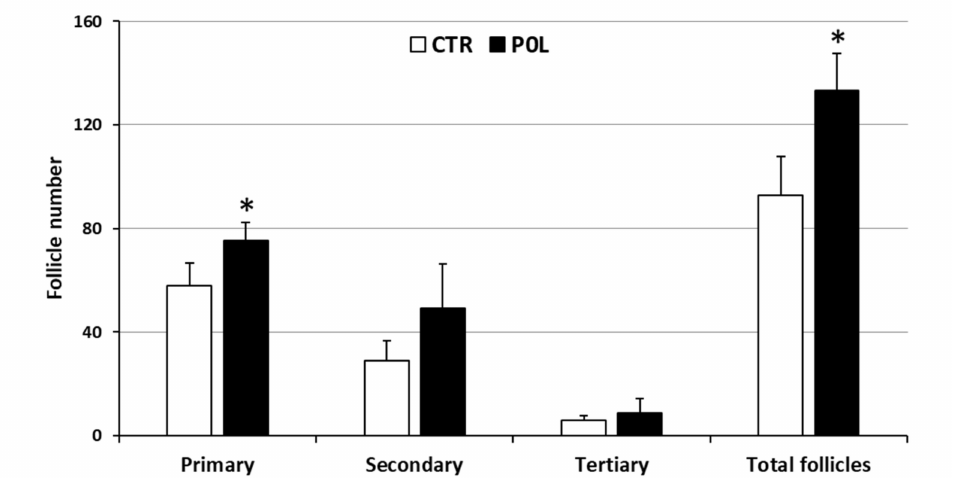
Figure 1. Primary, secondary and tertiary follicles counting in the ovary belonging to rabbits fed with a commercial pellet alone (CTR) or supplemented with an olive mill waste water product to reach a total concentration of 282.4 mg/kg of phenolic compounds (POL). Data represent the mean ± SD of eight replicates. Student’s t -test: * p < 0.05 CTR vs. POL (primary: p = 0.0217; secondary: p = 0.0717; tertiary: p = 0.3873; total follicles: p = 0.0083). Levene’s test: primary: p = 0.3571; secondary: p = 0.3480; tertiary: p = 0.5082; total follicles: p =